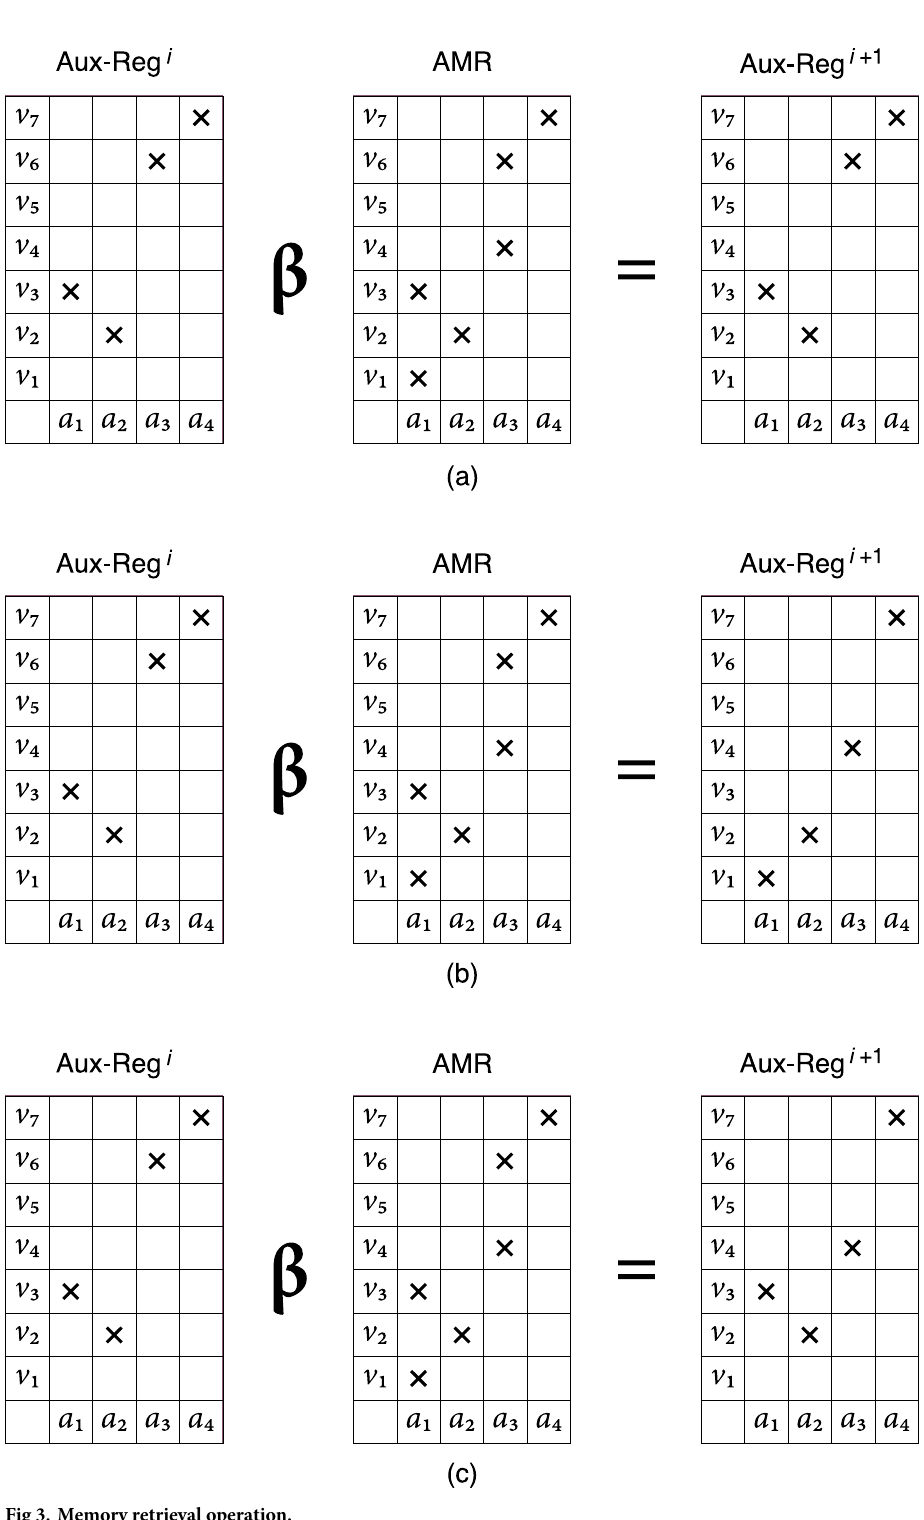
Fig 3. Memory retrieval